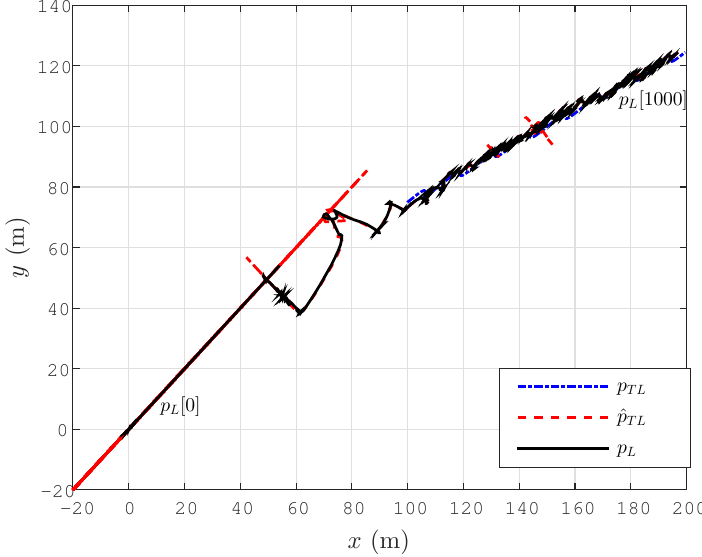
Figure 9. Lateral tracking control for a drifting target for the detailed motion dynamics model Equation